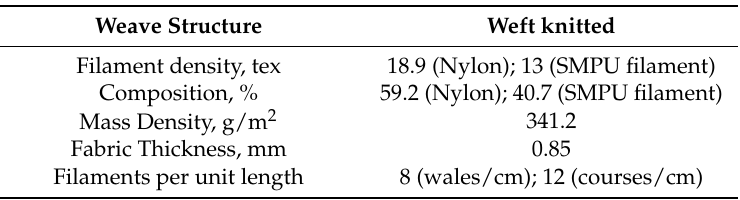
Table 1. Characteristics of the memory bandage.